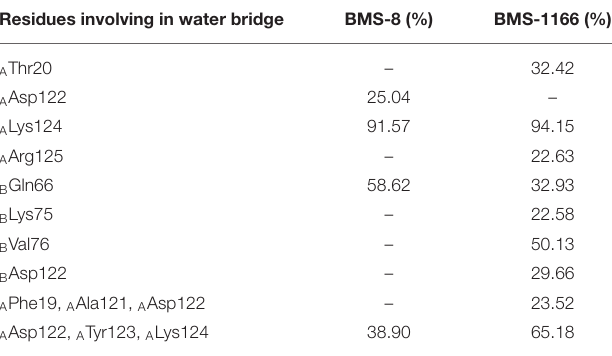
TABLE 4 | The water bridge with occupancies higher than 20.00% in the BMS-8 and BMS-1166 dimer